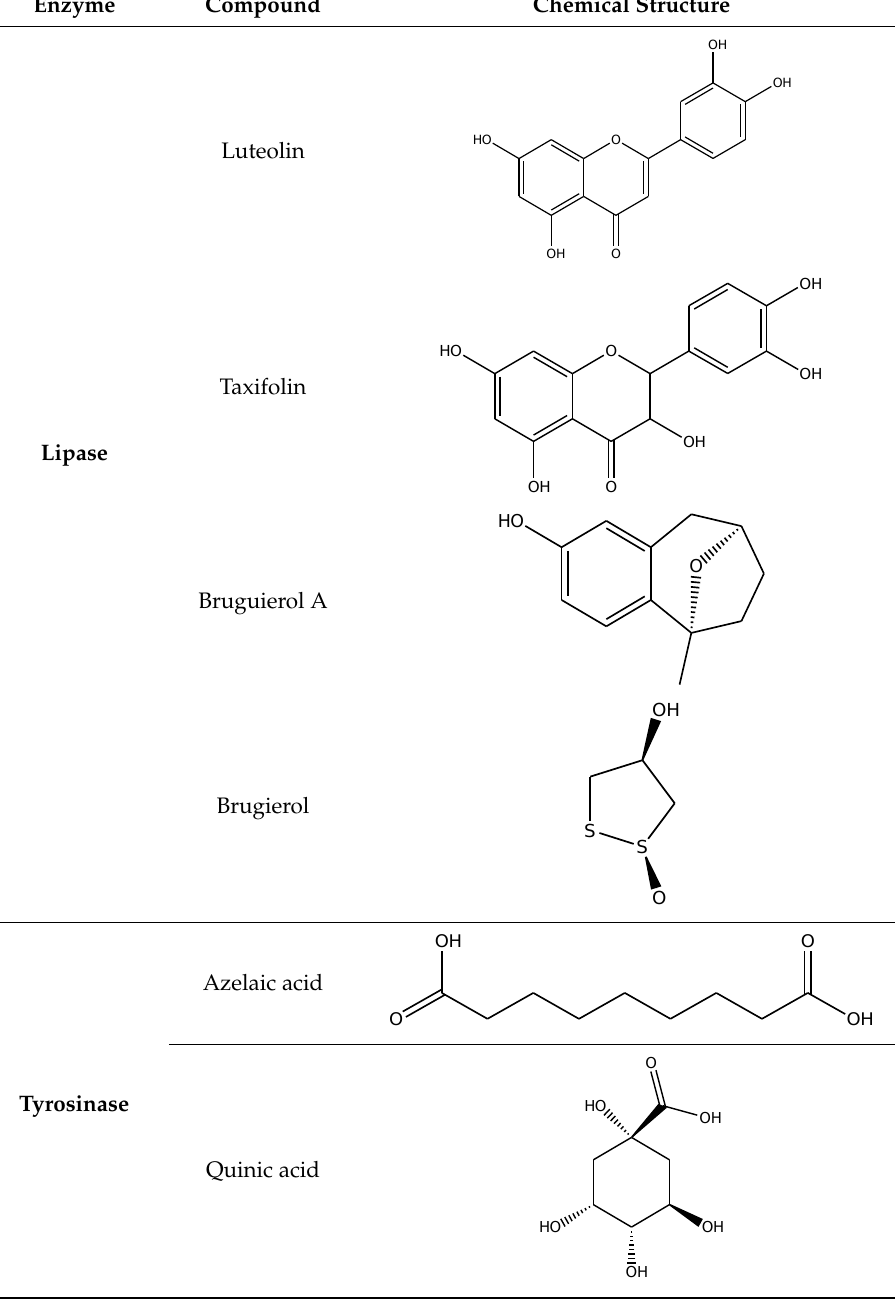
Table 9. Docking free energy and inhibition constants for the docked compounds.